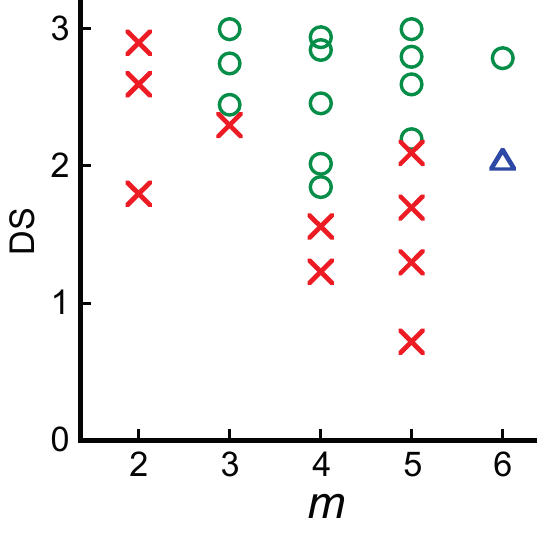
Figure 12. Miscibility map of different CE/PCL blends as a function of side-chain carbon number ( m ) and acyl DS. Symbols indicate whether a given CE/PCL blend is miscible (circle), immiscible (cross), or partially miscible (triangle). Reproduced with permission from ref. [45]. Copyright 2009 Elsevier